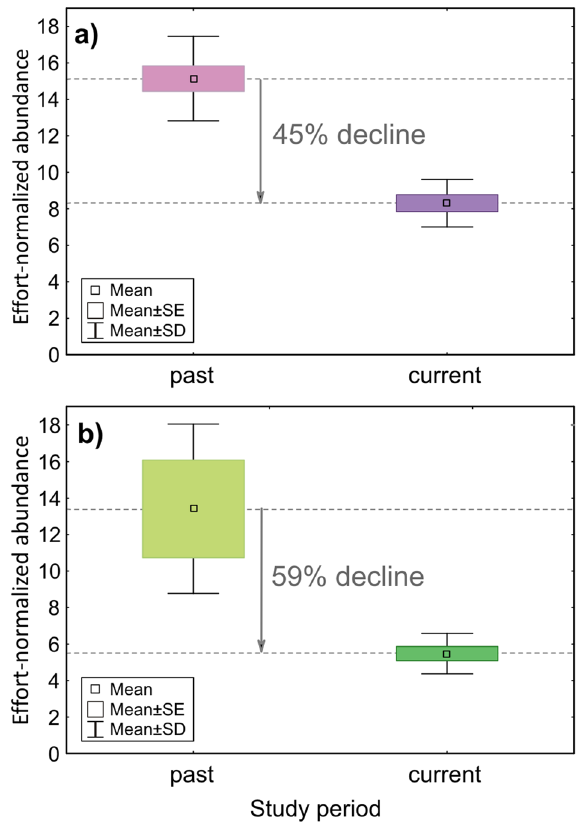
Figure 1. Change of abundance per unit sampling effort between past (base line) and current period in ( a ) alfalfa and ( b ) grassy field